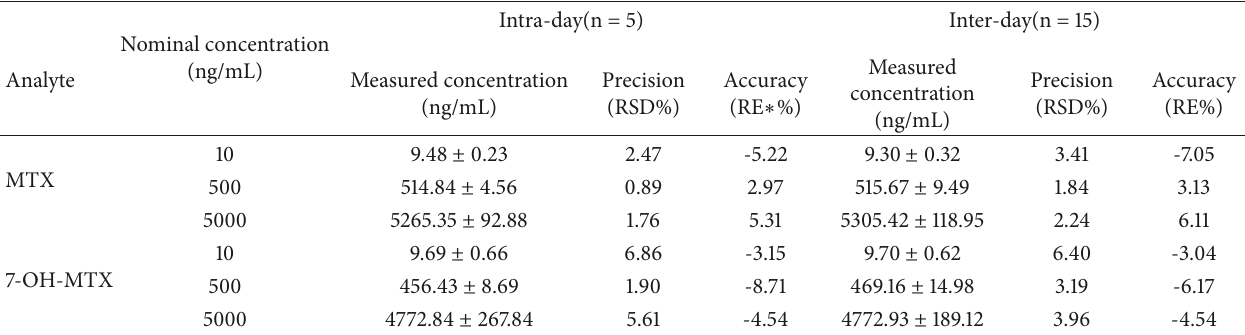
Table 3: Intraday and interday precision and accuracy of MTX and 7-OH-MTX in human plasma (n=5).